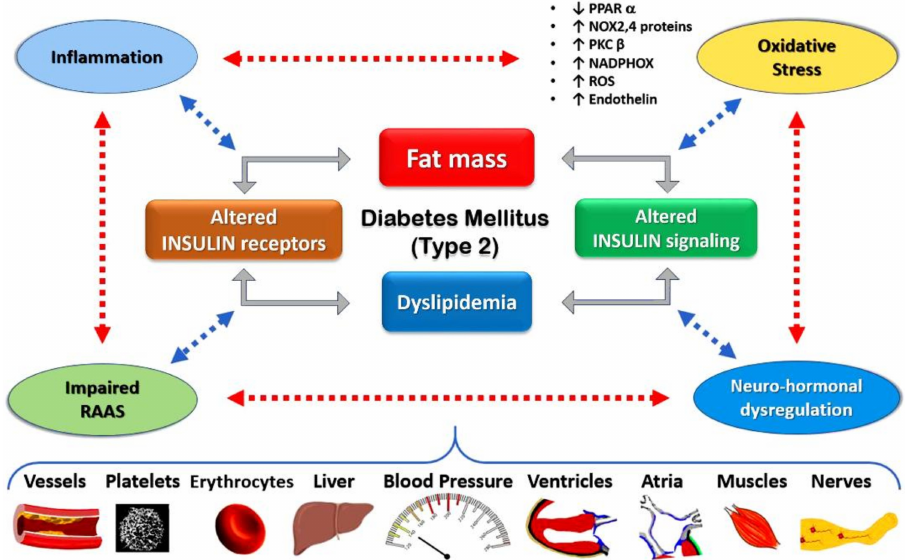
Figure 1. Pathophysiology of multiorgan damage in Type-2 Diabetes. Oxidative stress is involved in the pathophysiology and development of multiorgan disease inpatients with type 2 diabetes mellitus. It has been proposed that downregulation of PPAR α (small down arrow) induces dysregulation (overproduction, small up arrow) of the NOX proteins, which are predominantly expressed isoforms in cardiac tissue and contribute to the development of myocardial hypertrophy and cardiac dysfunc- tion. Increased vasoconstriction and peripheral arteriolar resistances also result from the activation of RAAS and neurohormonal dysregulation, often based upon overproduction of endothelin(s) (small up arrow) and reduced nitroxide synthase activity. Hyperglycemia activates most vascular stressors, which are responsible for micro- and macrovascular dysfunction and atherosclerotic complications in several districts. The overexpression of myocardial kinases β -isoform of PKC (small up arrow) is accompanied by upregulation of NAPHOX (small up arrow), one of the oxidative distressing media- tors in patients with diabetic cardiomyopathy. Chronically higher glycemic levels also simulate ROS production (small up arrow) and increase mitochondrial O 2 consumption. Oxidative stress also affects O 2 conveyance by erythrocytes and promotes activation of platelets. Transport of O 2 and nutrients to organs and tissues are damaged over time. For further explanation, see text. NADPHOX = NADPH oxidase; NOX2, 4 = nitrogen pxides 2, 4; PPAR α = peroxisome-proliferator-activated receptor α ; PKC β = protein kinase C isoform β ; RAAS = renal–angiotensin–aldosterone system; ROS = reactive oxygen